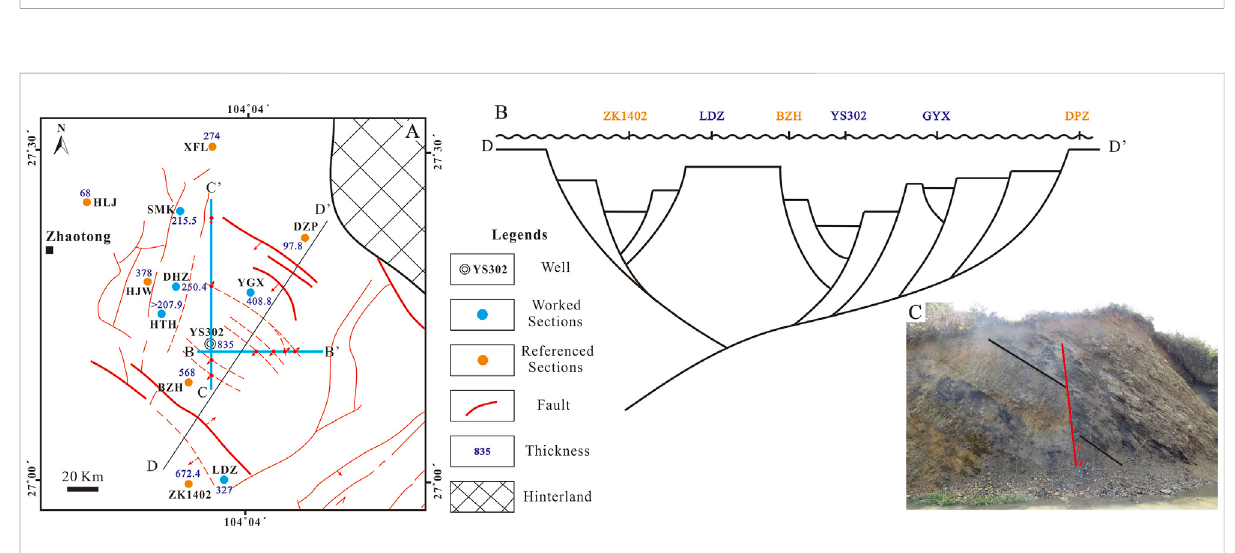
FIGURE 4 The structural pattern in northwestern Weining area. (A) The distribution of fault systems and of seismic pro fi le locations in the northwestern Weining area (the fault system distribution was modi fi ed after Mao, 1997). (B) Synsedimentary extension fault zone in D-D ’ section. (C) Synsedimentary extension fault within the Jiusi Formation, outside of SMK